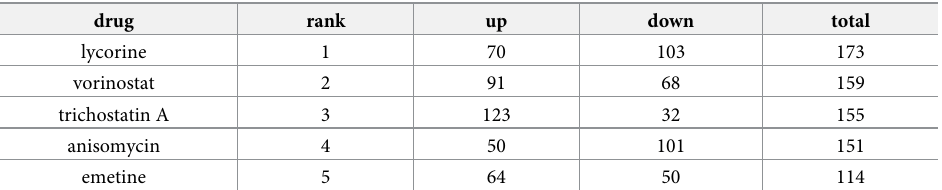
Table 2. Drugs matched to i-DEG pattern in initial matching. drug